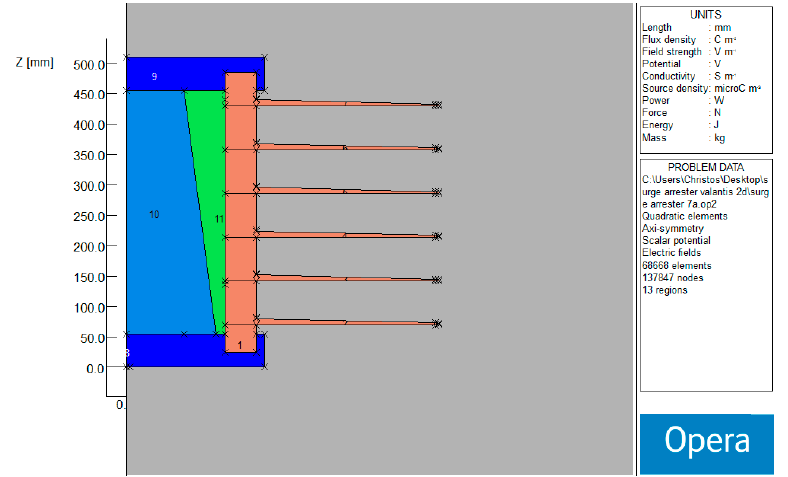
Figure 7. Arrester’s model with non uniform increase of the varistor’s diameter (case 1).